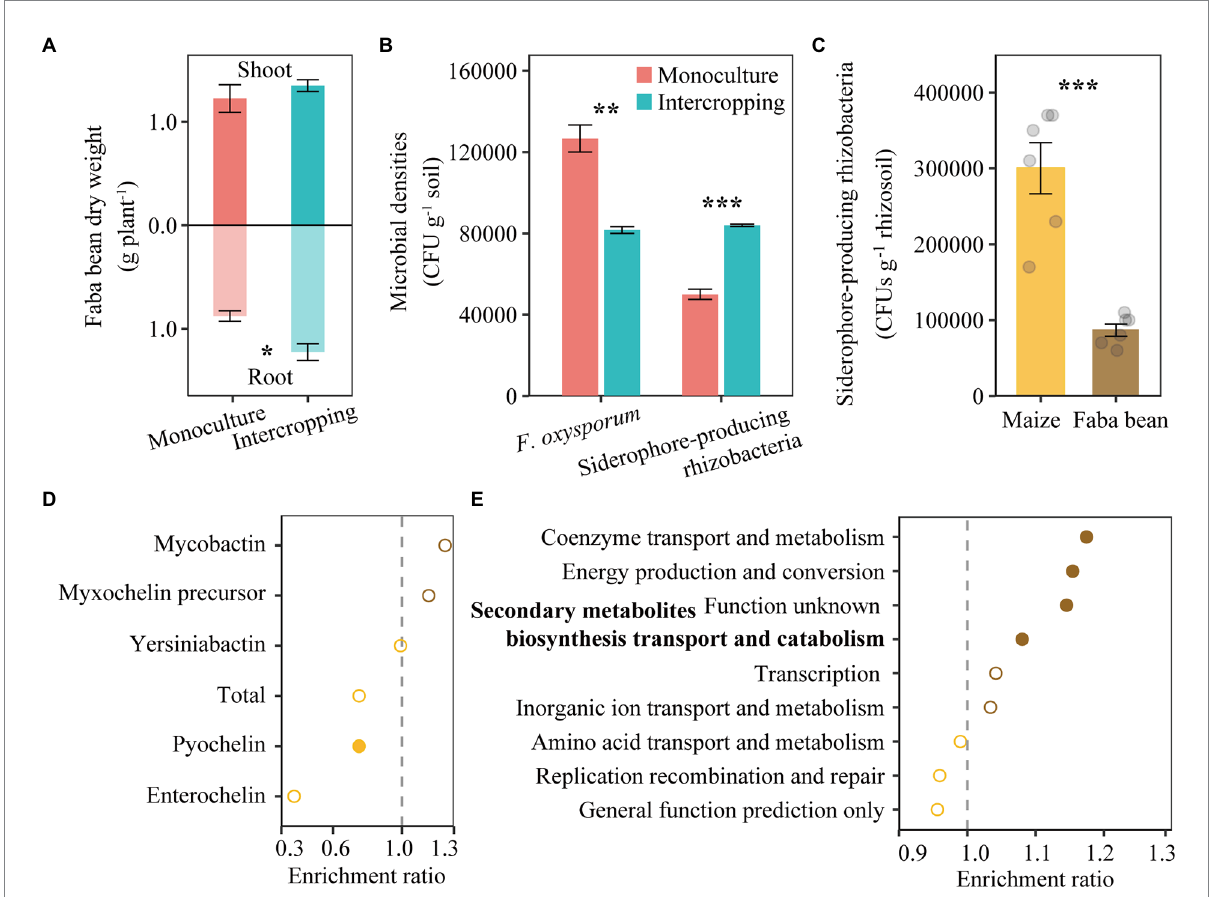
FIGURE 4 Shoot and root dry weights of faba bean in monoculture and intercropping (A) . Abundance of cultivable F. oxysporum and siderophore-producing rhizobacteria in faba bean rhizosphere in the pot experiment (B) . Number of siderophore-producing rhizobacteria in rhizosphere of maize and faba bean in the field experiment (C) . Relative abundance of nonribosomal peptide synthetase (NRPS) gene in maize and faba bean rhizosphere soil based on metagenome sequencing (D) . Bacterial gene ontology (GO) analysis for all genes related to iron metabolism, showing enriched (right next to the dash line) or depleted (left next to the dash line) in faba bean rhizosphere (E) . In panel (A,B) , data ( n = 3; mean ± S.E.) of faba bean samples collected from monoculture and intercropping are presented. In panel (C–E) , data ( n = 6; mean ± S.E.) of rhizosphere soil samples